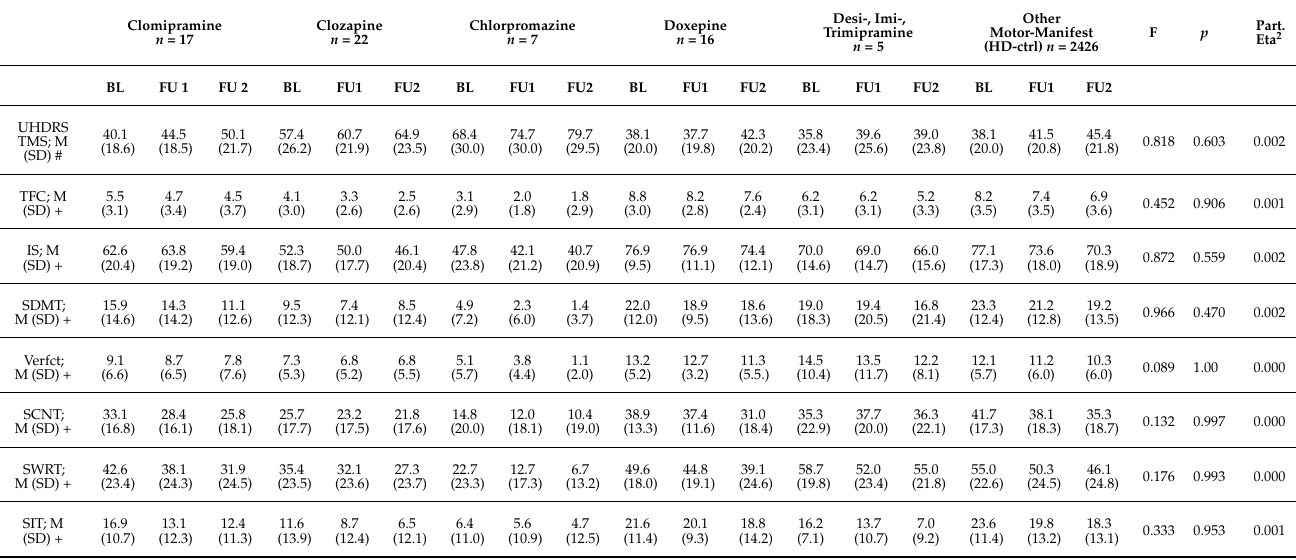
Table 3. Longitudinal analyses of motor, functional and cognitive